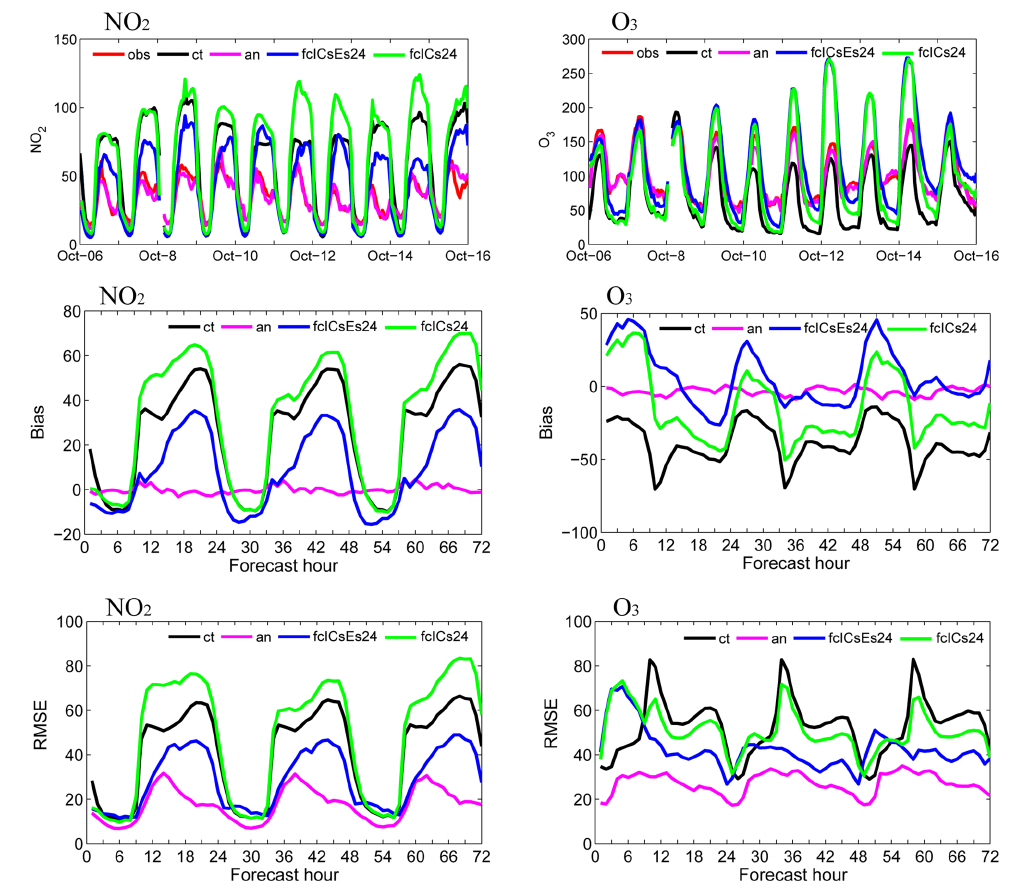
Figure 11. NO 2 and O 3 time series of the hourly pollutant concentrations in the Pearl River delta region (PRD; 21–24 ◦ N, 112.5–115 ◦ E) obtained from observations (referred to as “obs”, red line), the control run (referred to as “ct”, black line), the analysis (referred to as “an”, pink line), the first-day forecast from fcICsEs (referred to as “fcICs24”, blue line), and the first-day forecast from fcICs (referred to as “fcICs24”, blue line). The bias and RMSEs of surface NO 2 and O 3 as a function of forecast range calculated against all the independent observations (34 sites) over the PRD region. Units: µgm − 3